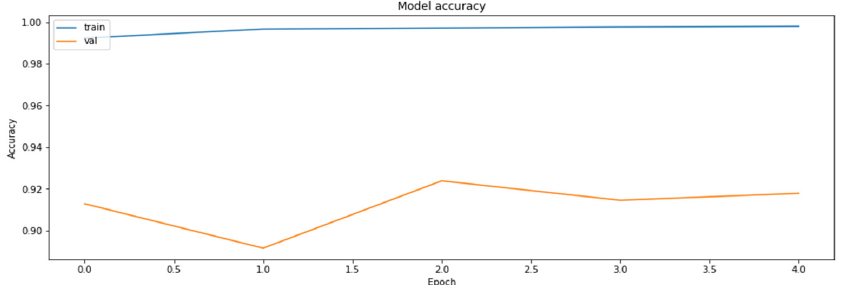
Figure A4. The accuracy of the model for the training and the validation datasets obtained during the training of the model with the weights clustered with the linear initialization of 32